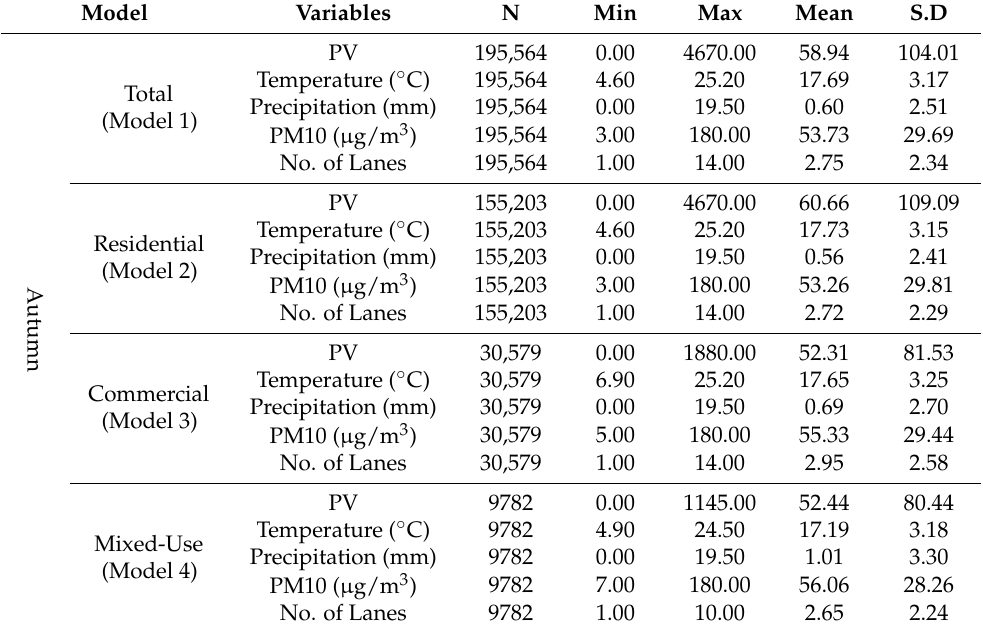
Table 6. Descriptive statistics for the ratio scale